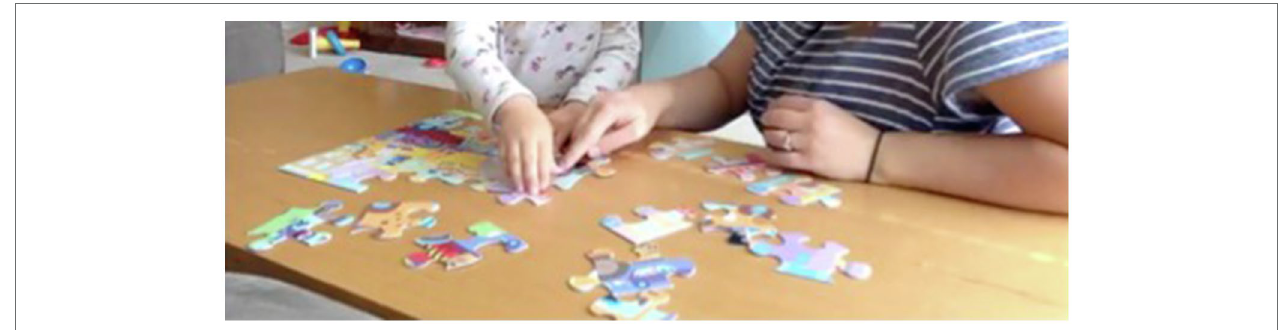
FIGURE 1 | Camera set-up for the puzzle